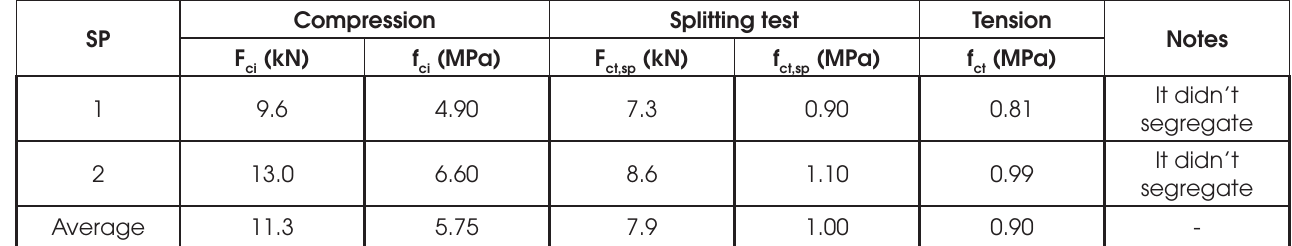
Description of SLCEB from preliminary test Compression Splitting test SP